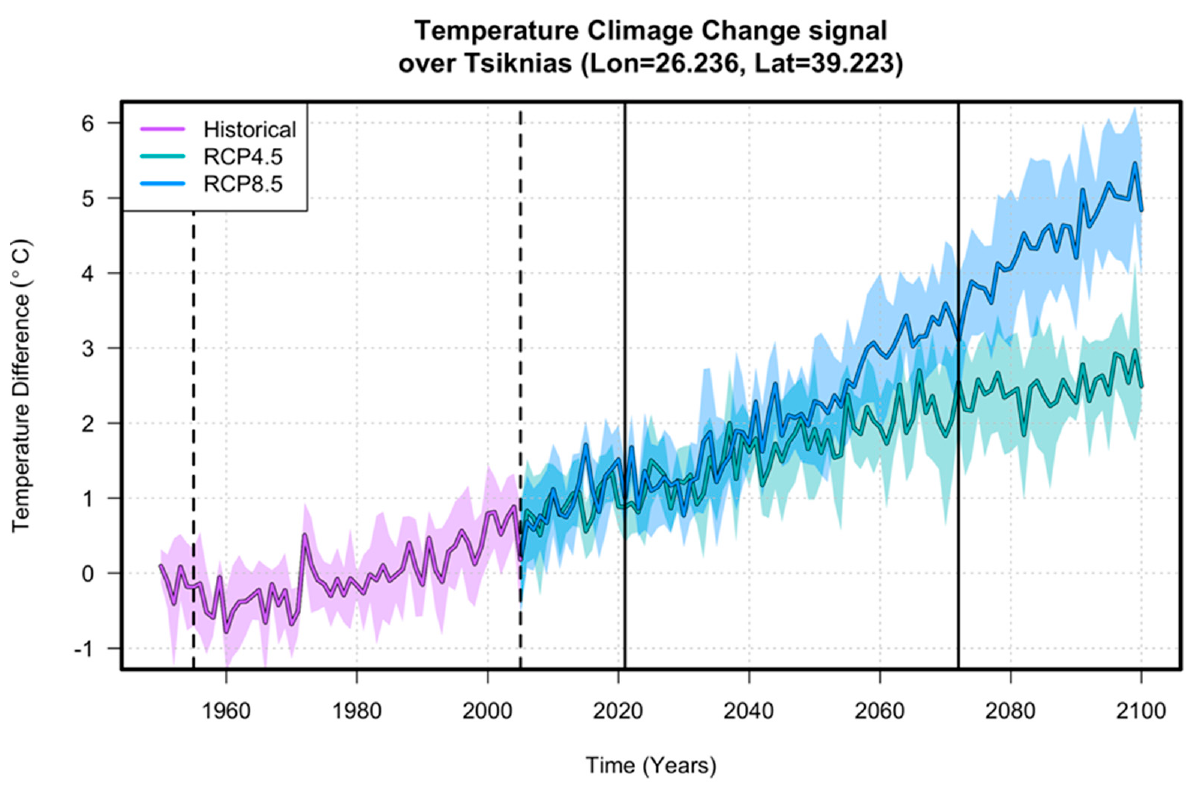
Figure 8. Multi-model simulated time series at Tsiknias (Lesvos) from 1950 to 2100 indicating the changes in annual pre- cipitation relative to the period 1961–1990 for the historical, RCP 4.5, and RCP 8.5 experiments. Lines and shades represent the ensemble mean and standard deviation of all the available CORDEX models, respectively. Vertical dashed and con- tinuous lines delimit the periods 1955–2005 and 2021–2071, respectively.